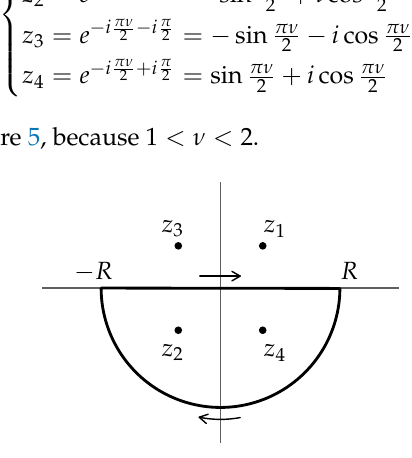
Figure 5. Integration contour for x >